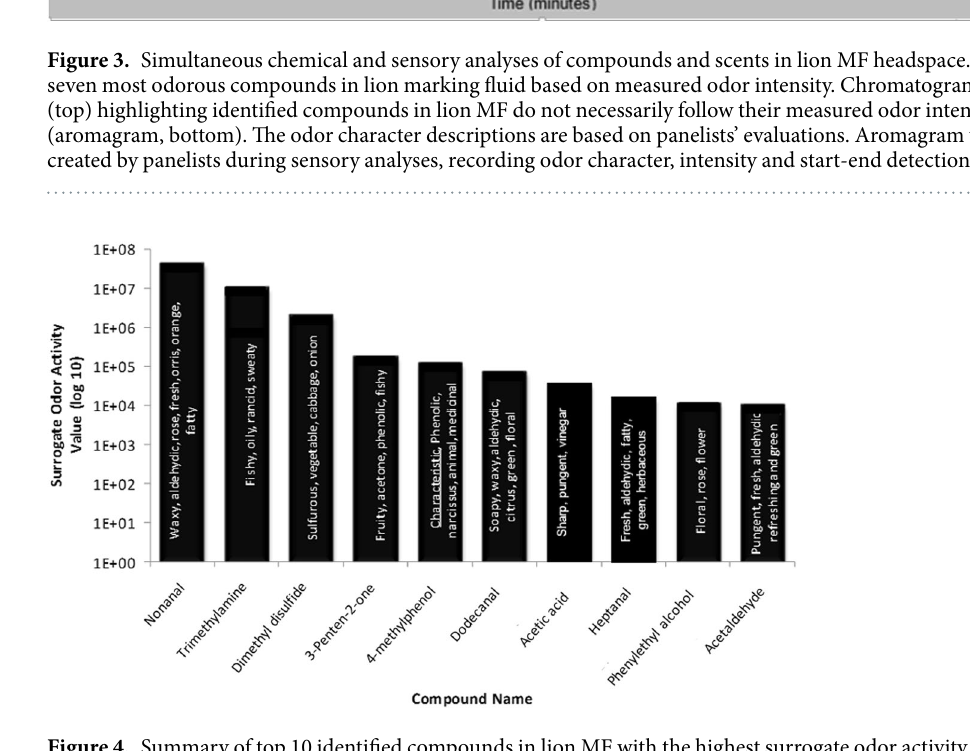
Figure 4. Summary of top 10 identified compounds in lion MF with the highest surrogate odor activity values, OAV (OAV = peak area count/odor detection threshold) and their odor character